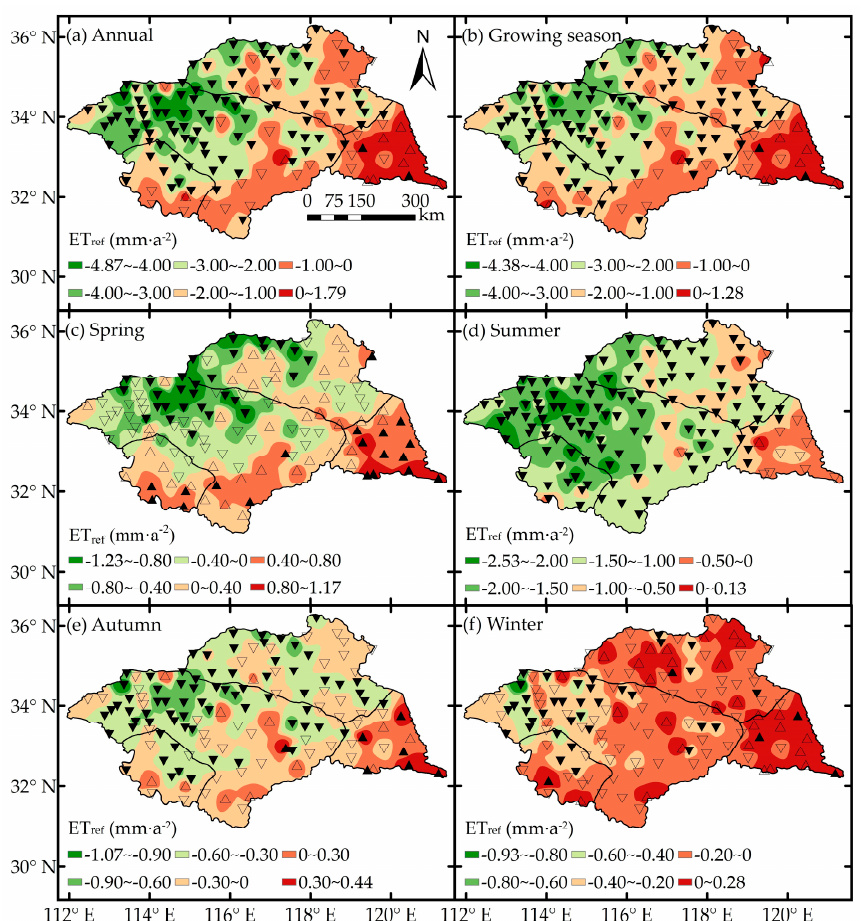
Figure 5. Spatial distribution maps of ( a ) annual; ( b ) growing season; ( c ) spring; ( d ) summer; ( e ) autumn; and ( f ) winter ET ref trends during 1961–2014 in the HRB. The upward and downward triangles represent increasing and decreasing ET ref trends The solid black triangle represents a significance level of 0.05.